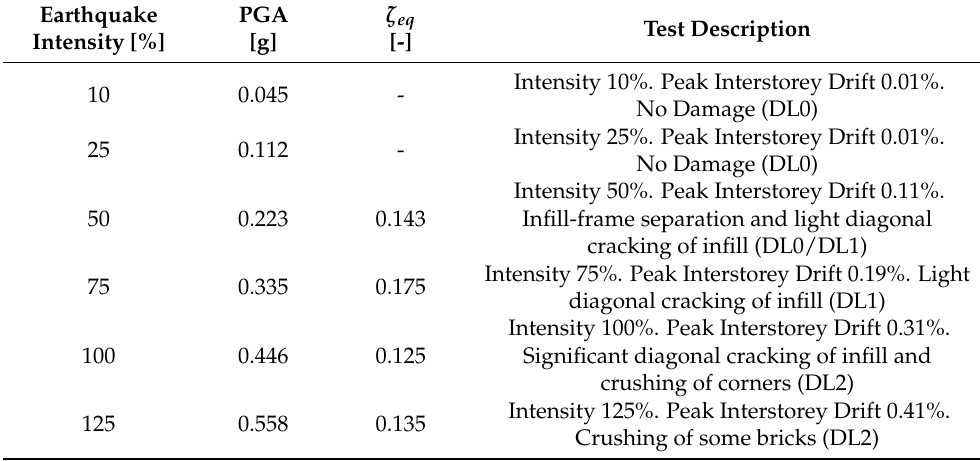
Figure 4. Damage condition at the end of the loading sequences for F2_3S_M and F2_4S_M. Table 3. Pseudo-dynamic test results and damage description for F2_3S_M [20].